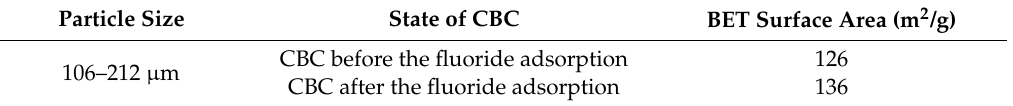
Table 3. BET surface area of CBC before and after the fluoride adsorption.